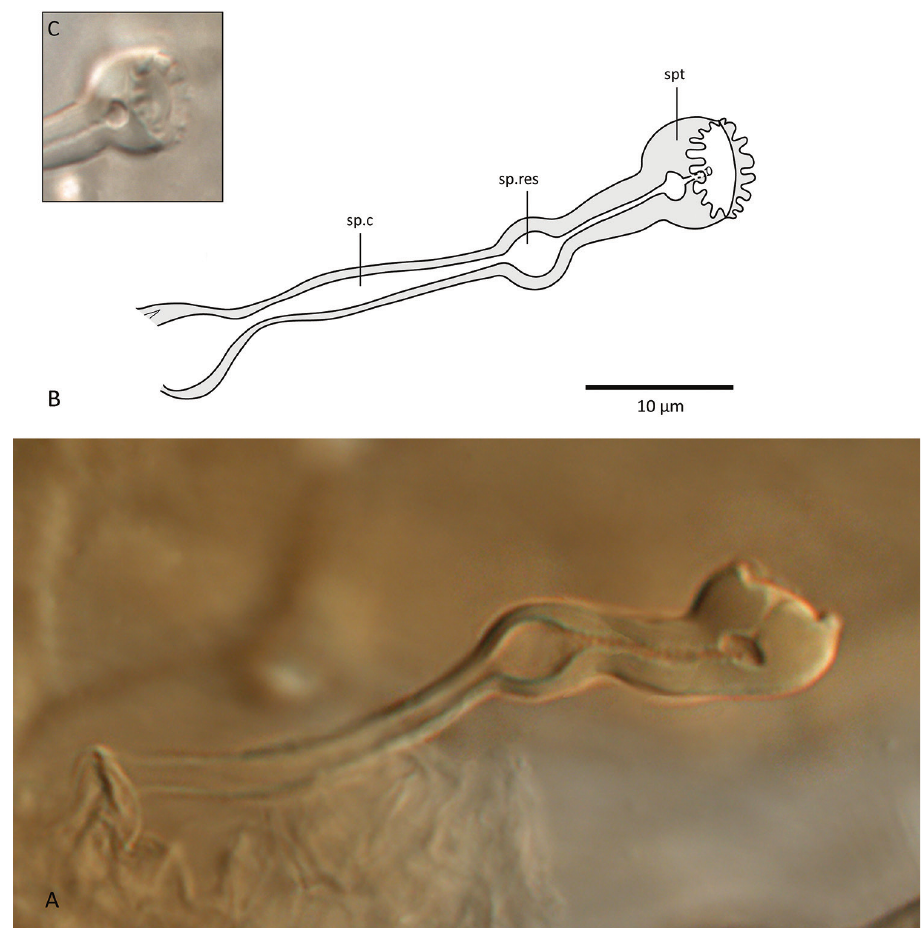
Plate 1. Zygoseius papaver sp. n., female, A, B spermathecal apparatus in two different females. Abbrevia- tions: sp.c.= spermatic canal, sp.res.= sperm reservoir, spt.= spermatheca C